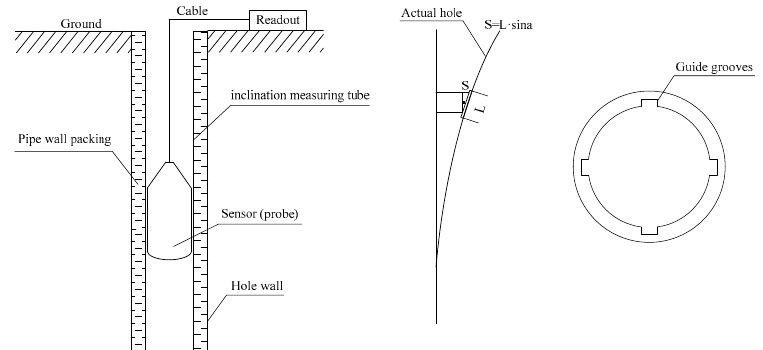
Figure 19. Constitution and operating principle of inclinometer.